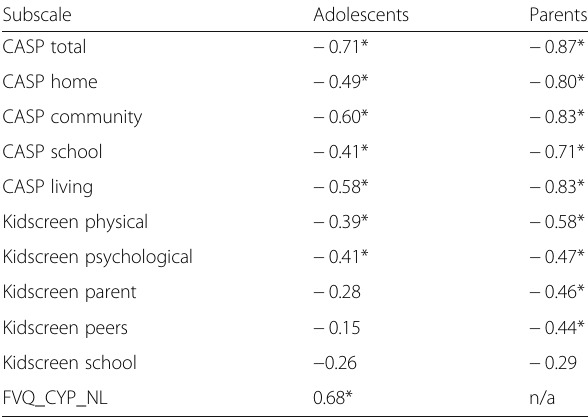
Table 4 Correlation coefficients of the PAI-CY 13 – 17 with the CASP, Kidscreen and FVQ_CYP_NL